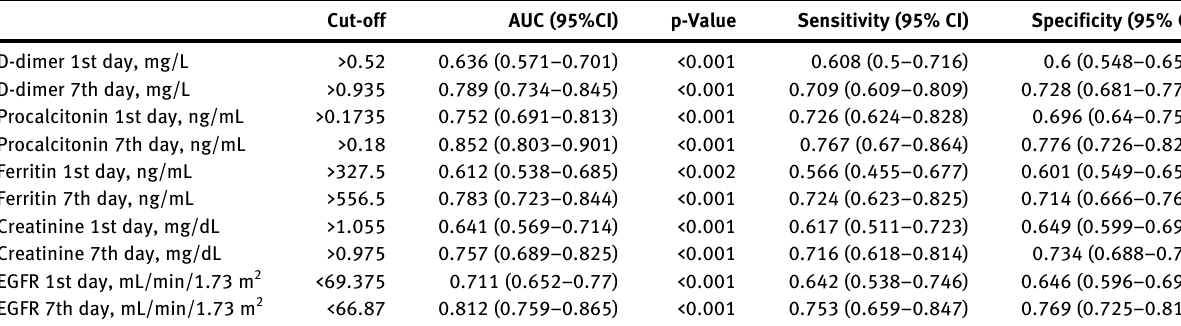
Table  : ROC analysis results of the exitus group.